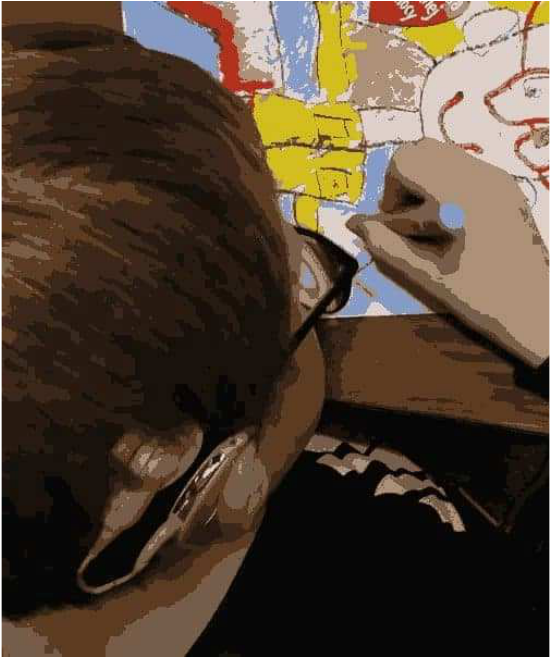
Figure 2. Child with the ear worn cochlear implant processor.